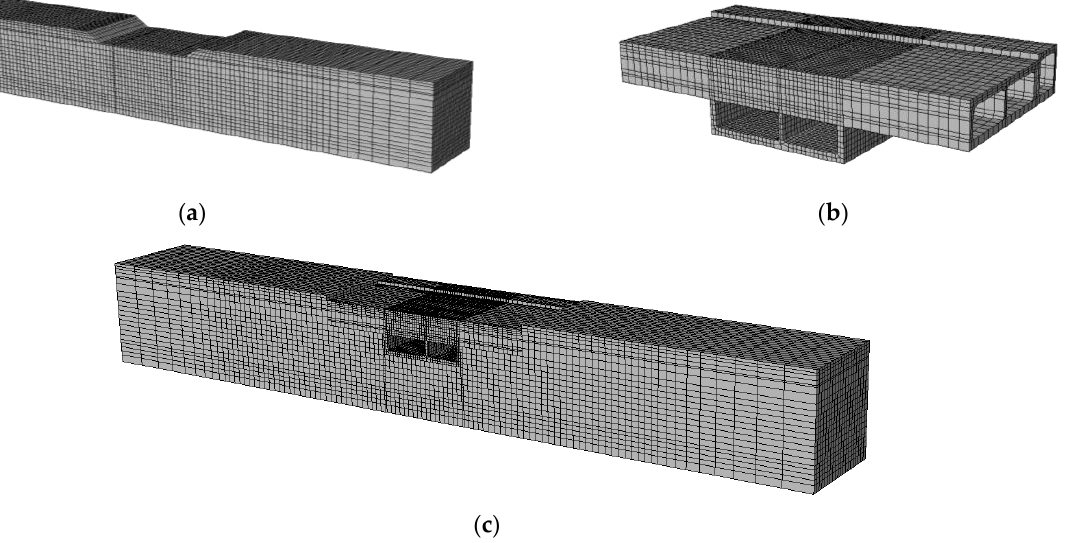
Figure 5. Numerical model of tunnel frame structure of Huayuan Road: ( a ) solid model; ( b ) tunnel model; ( c ) entire model.